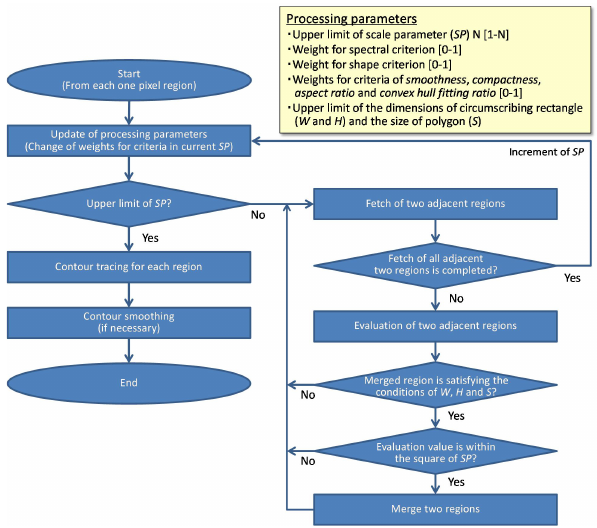
Figure 2. Flowchart of stone polygon extraction by extended multiscale image